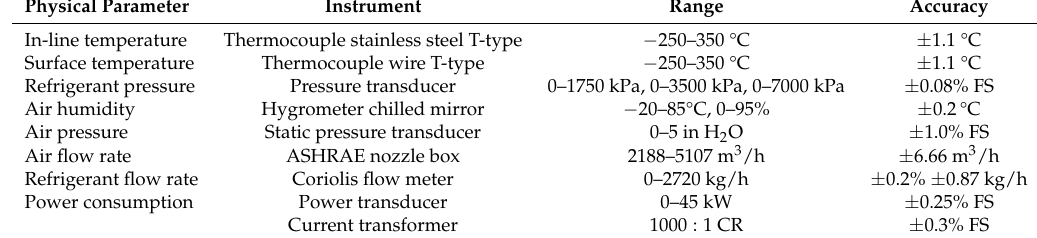
Table 1. Experimental setup measurement instrument and their accuracy.